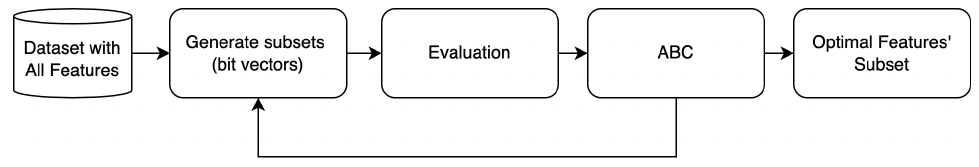
Figure 1. The general schematic approach to ABC-based feature